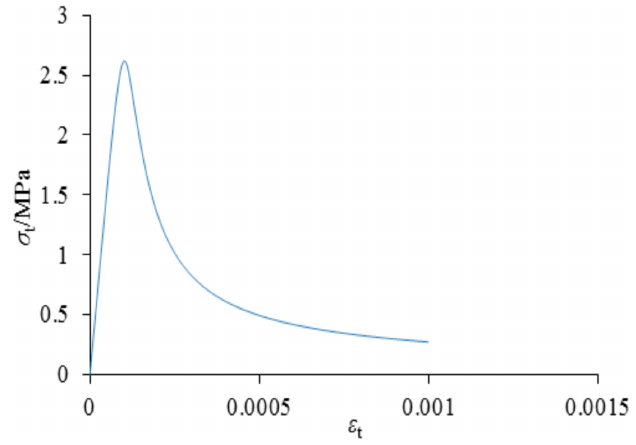
Figure 14. Tensile stress-strain curve of recycled concrete.